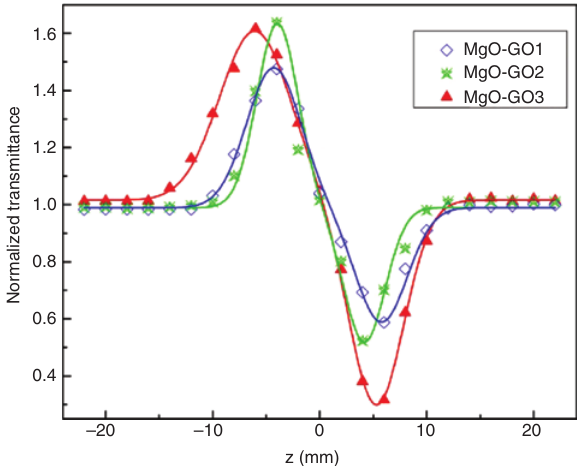
Figure 7: Open-aperture Z-scan data and fitting curves for MgO-GO